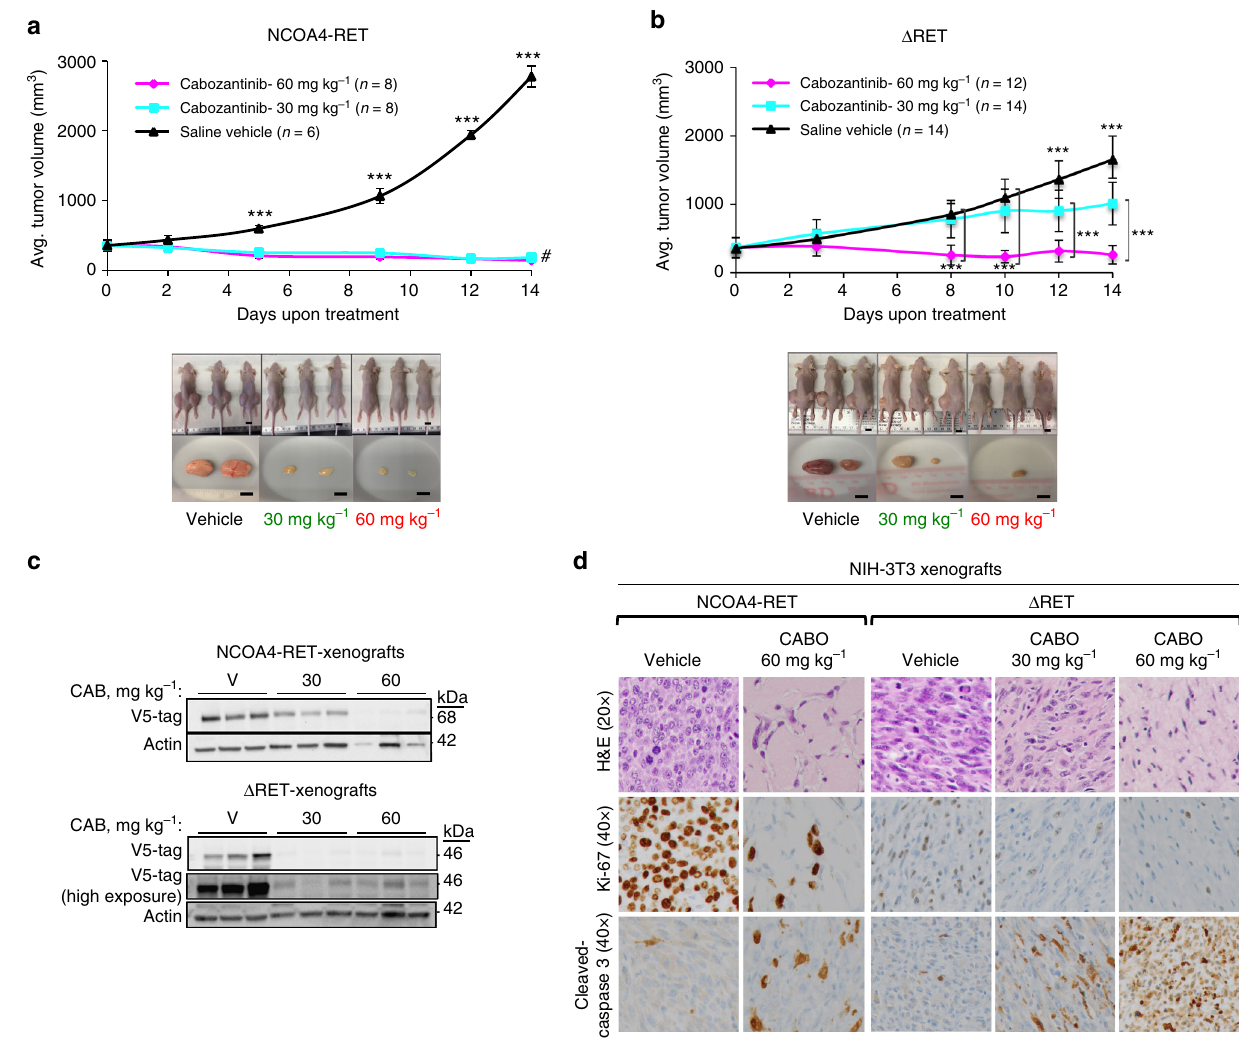
Fig. 5 Cabozantinib inhibits tumor growth driven by RET fusions. Mean tumor volume was measured in NIH/3T3 xenograft tumors driven by a NCOA4- RET ( n = 8 or 6 injection sites per group) or b Δ RET ( n = 14 or 12 injection sites per group) under treatment with either cabozantinib at 30 mg kg − 1 , 60 mg kg − 1 , or saline vehicle control for 14 days. Treatment started at day 0. Error bars represent mean ± s.d., ***( p ≤ 0.001) represent comparisons between both treatment groups and vehicle-treated controls when depicted above the vehicle curve or between indicated groups and #( p ≤ 0.001) represents comparisons between day 0 and day 14 for the treatment groups (two-way ANOVA with Tukey ’ s multiple comparison test). Mouse and tumor images are representatives from each treatment group at the end of study after 14 days of treatment. Scale bars indicate 10 mm. c Immunoblot of tumor protein lysates collected at the end of 14 days of treatment to measure changes in NCOA4-RET, Δ RET (detected by V-5 tag antibody, actin as loading control). Mice were treated on the day of tumor harvest for 4 h with saline vehicle or cabozantinib (30 or 60 mg kg − 1 ) and sacri fi ced. n = 3 xenograft samples per treatment condition. d Representative hematoxylin and eosin (H&E) staining of tumor tissue revealing a high grade sarcomatoid distribution (top row, ×20 magni fi cation) and immunohistochemistry of markers Ki-67, Cleaved Caspase-3 for comparison between vehicle and cabozantinib treatment groups in NCOA4-RET and Δ RET xenograft experiments (middle and bottom row, ×40 magni fi